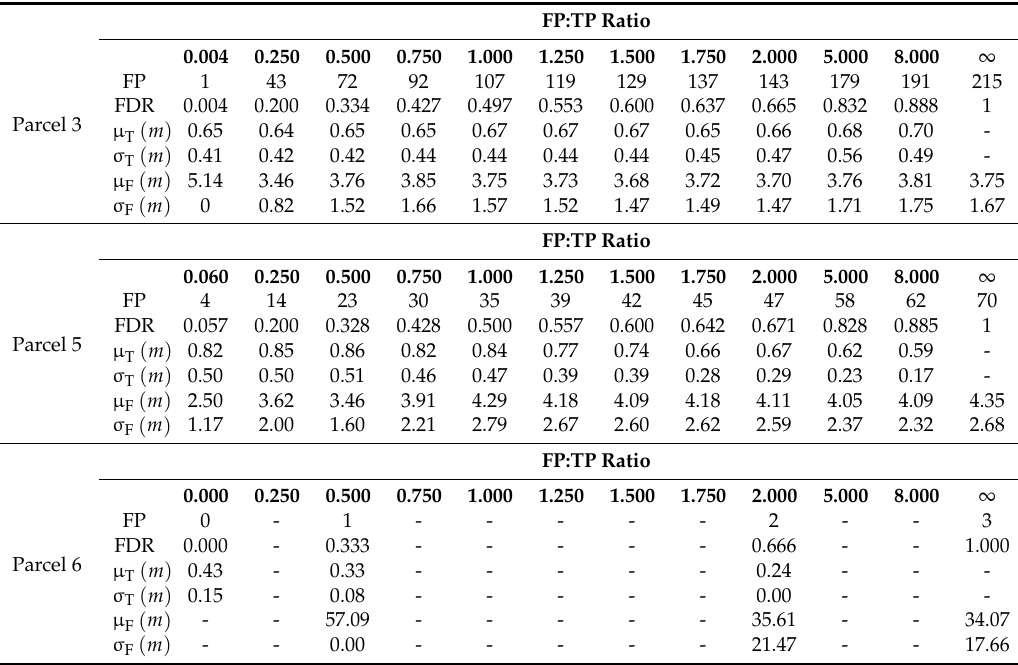
Table 8. Specifications and quality measures for the generated test training datasets and the created templates at the different FP:TP ratio thresholds in parcels 3, 5, and 6 (the column highlighted in gray indicates the respective values for the original crowdsourced data).